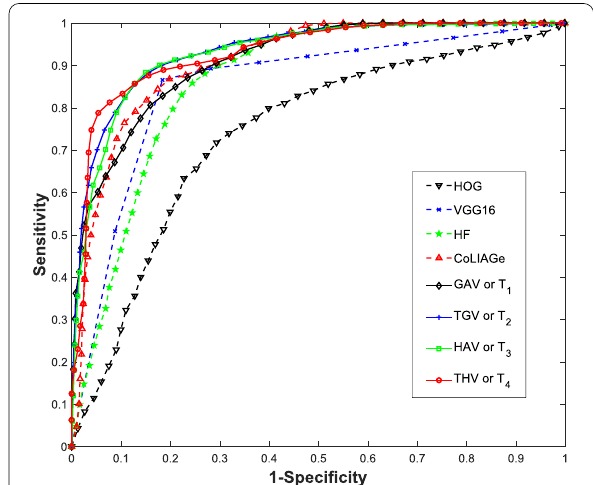
Fig. 6 The ROC curves presented for each comparative method and our proposed method. For visual clarity, only the highest performing gradient vector and Hessian vector curves are shown where HF represents the Haralick features